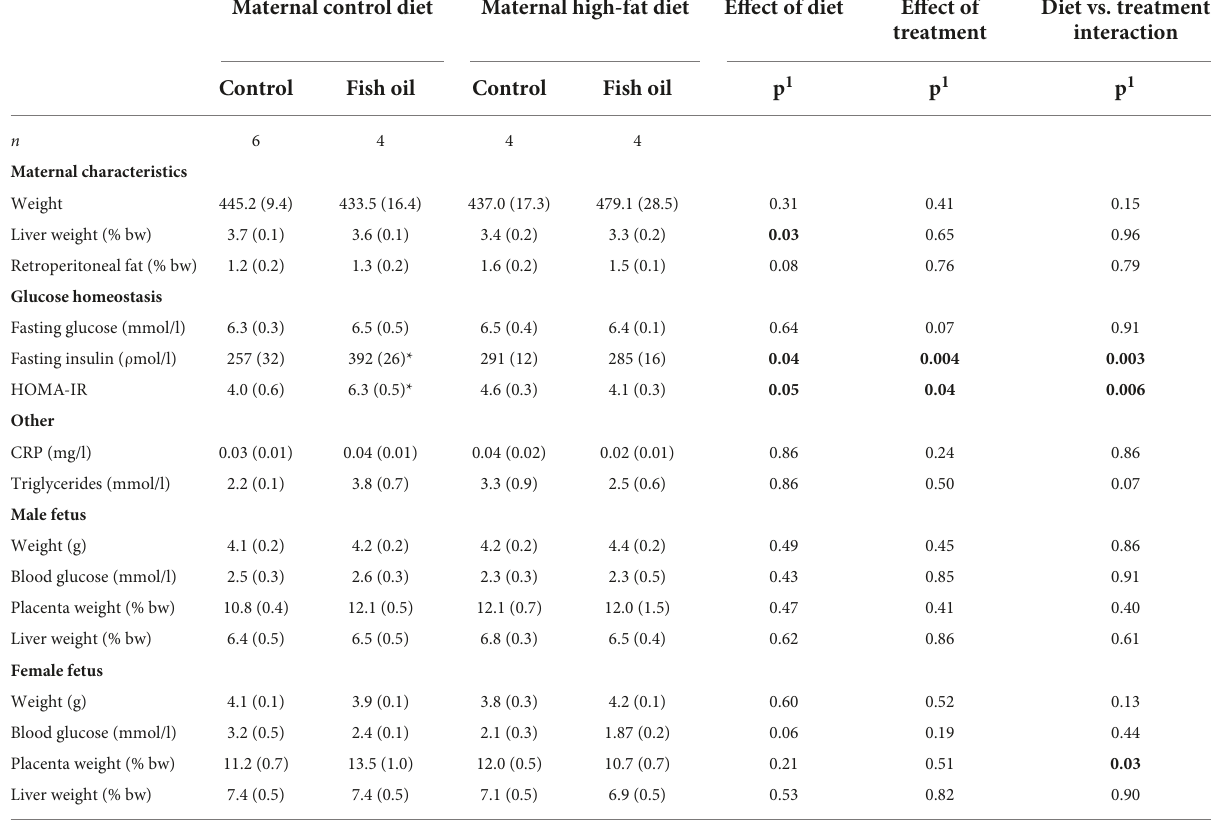
TABLE 4 Characteristics and metabolic parameters of dams culled on day 20 of